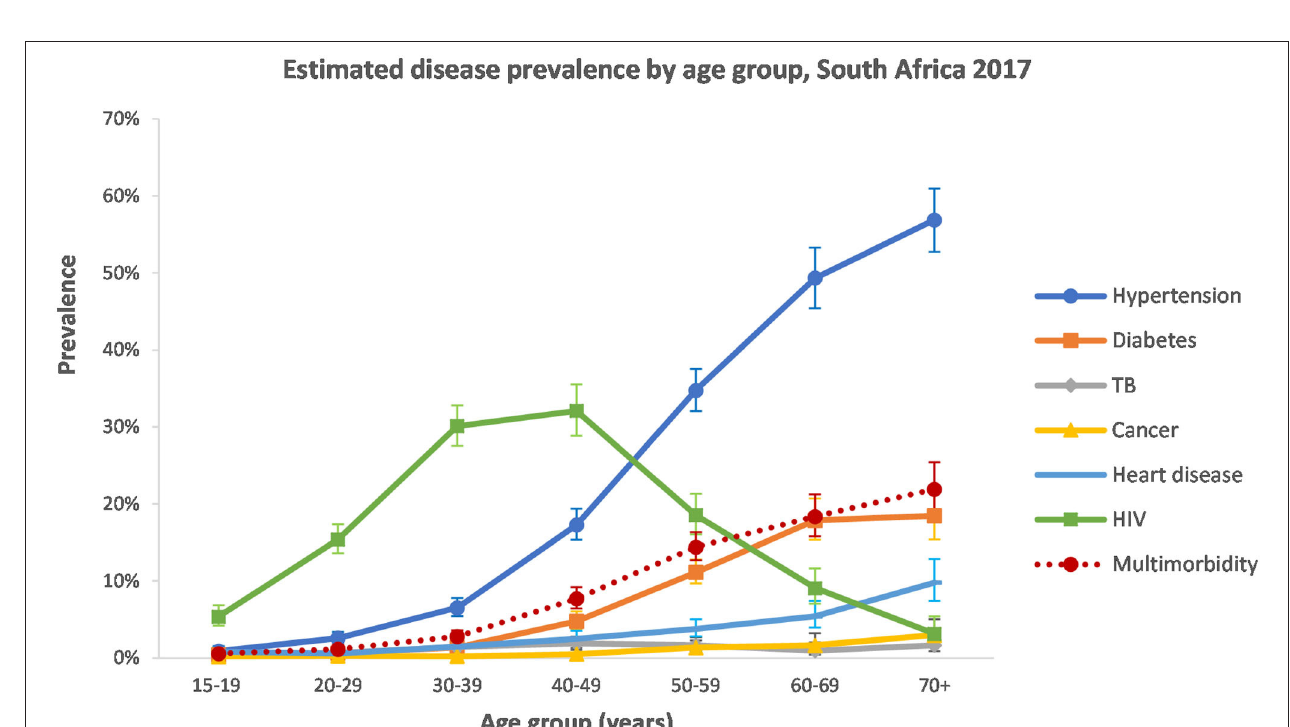
FIGURE 1 | Estimated disease prevalence by age group in South Africa, 2017 (weighted).